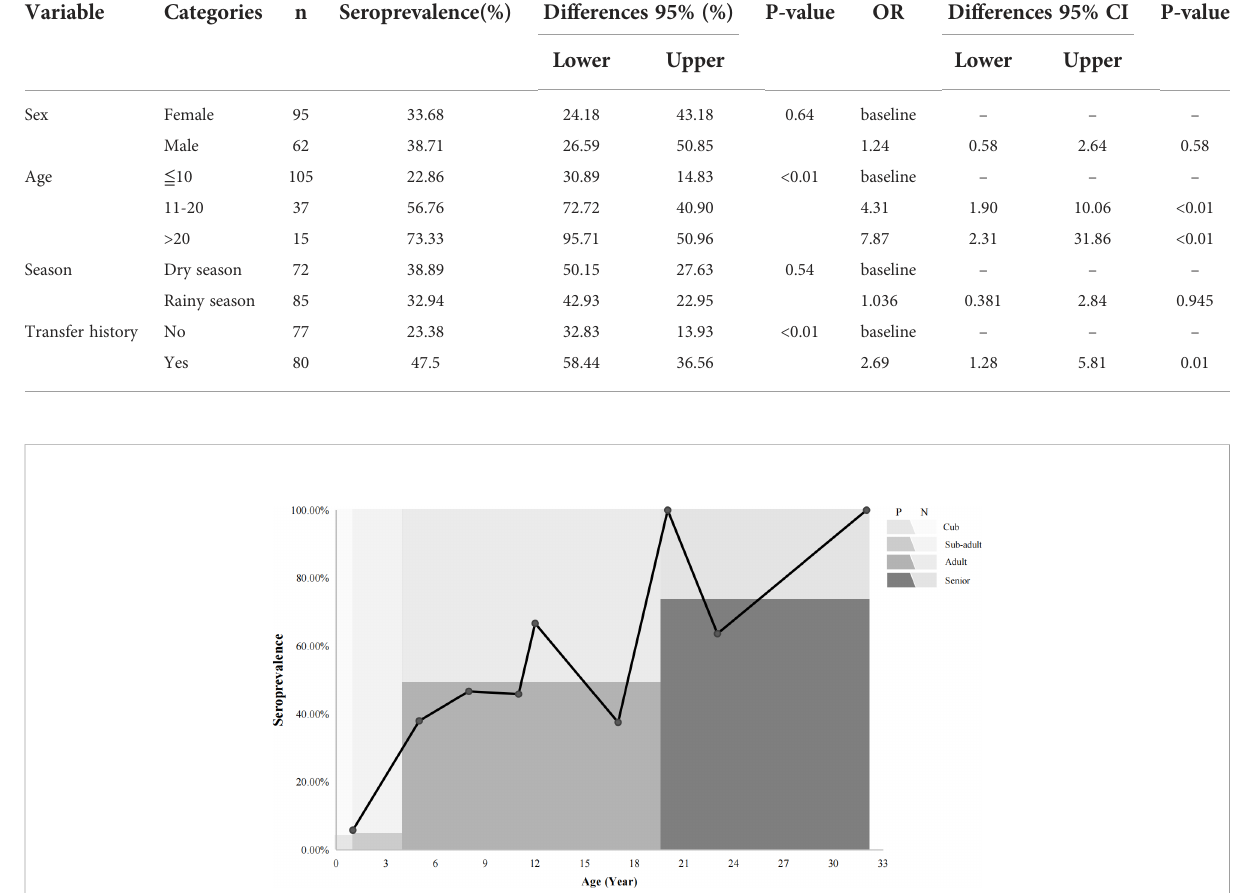
FIGURE 2 The relationships between the prevalence of giant pandas and age trends. P: positive, N: negative. The line chart shows the seroprevalence in different ages. The colors in the background indicated the percentage of the seroprevalence (The dark color: positive; The light color: negative) in different age groups.